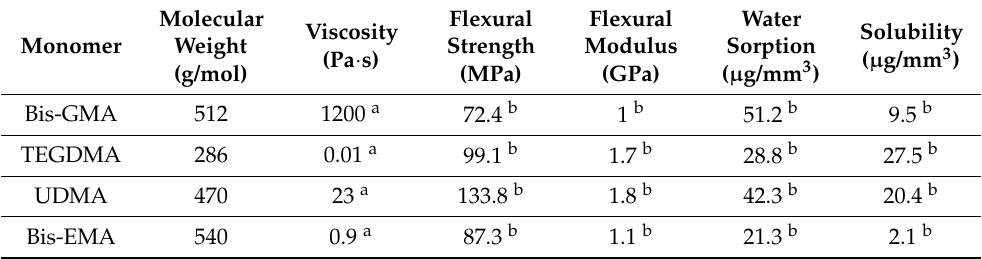
Table 1. Selected properties of A-glycidyl methacrylate (Bis-GMA), triethyleneglycol dimethacrylate (TEGDMA), urethane dimethacrylate (UDMA), and ethoxylated bisphenol-A dimethacrylate (Bis- EMA)—the most popular monomers used in dental composites. Molecular Monomer Weight